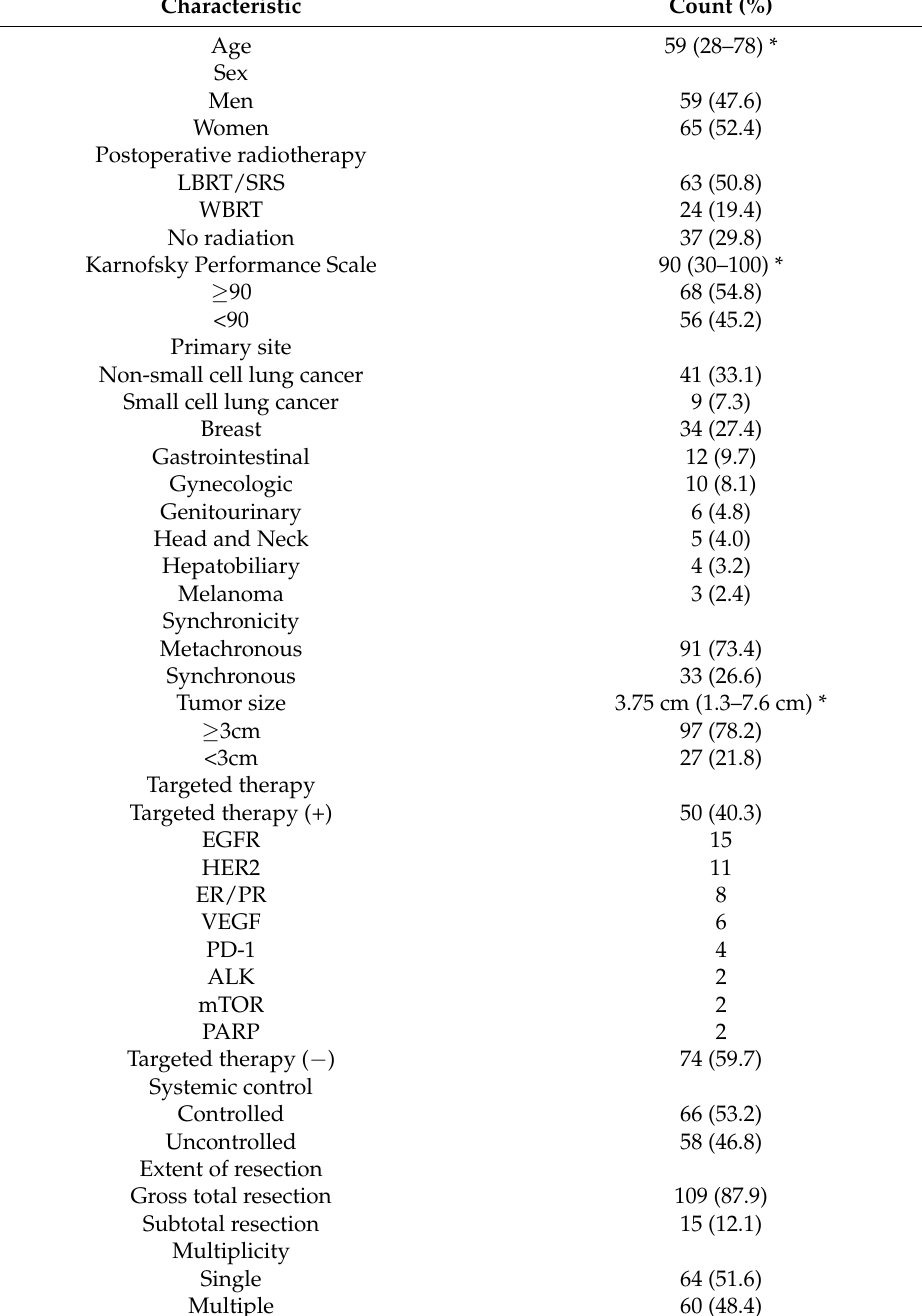
Table 1. Patient